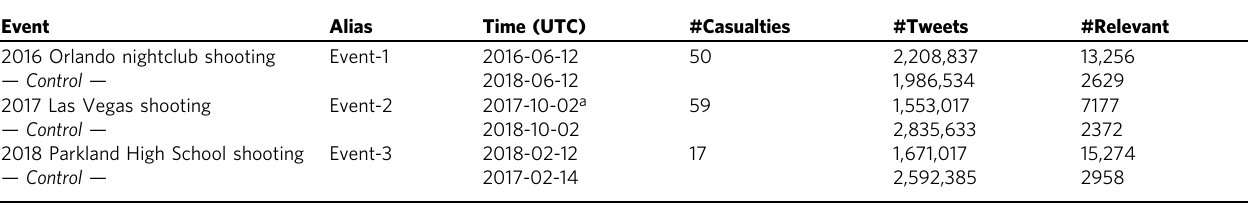
Table 1 List of three major mass shooting events during 2016 – 2018 used in this